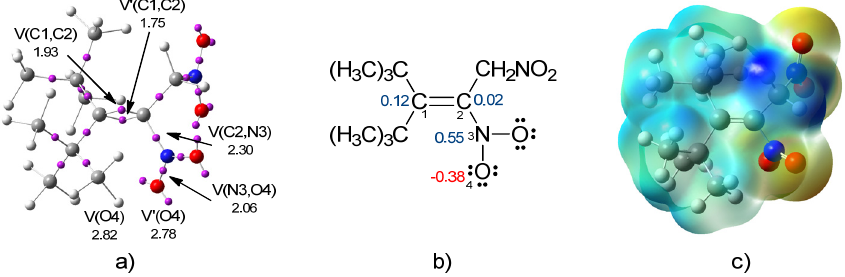
Figure 1. ( a ) The ELF basin attractor positions, together with the most important valence basin pop- ulations; ( b ) the proposed ELF-based Lewis-like structures, together with the natural atomic charges, obtained through an NPA; ( c ) and MEP of 3-tert-butyl-4,4-dimethyl-1,2-dinitro-pent-2-ene ( 2a